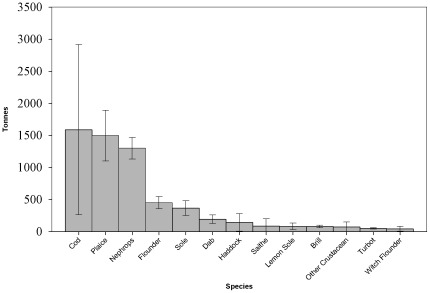
The official Danish landing statistics (www.fvm.dk) for the Kattegat: 1997 to 2008.Species are ranked according to their relative importance by weight. Average value in thousands with standard deviation for the 12 years investigated.